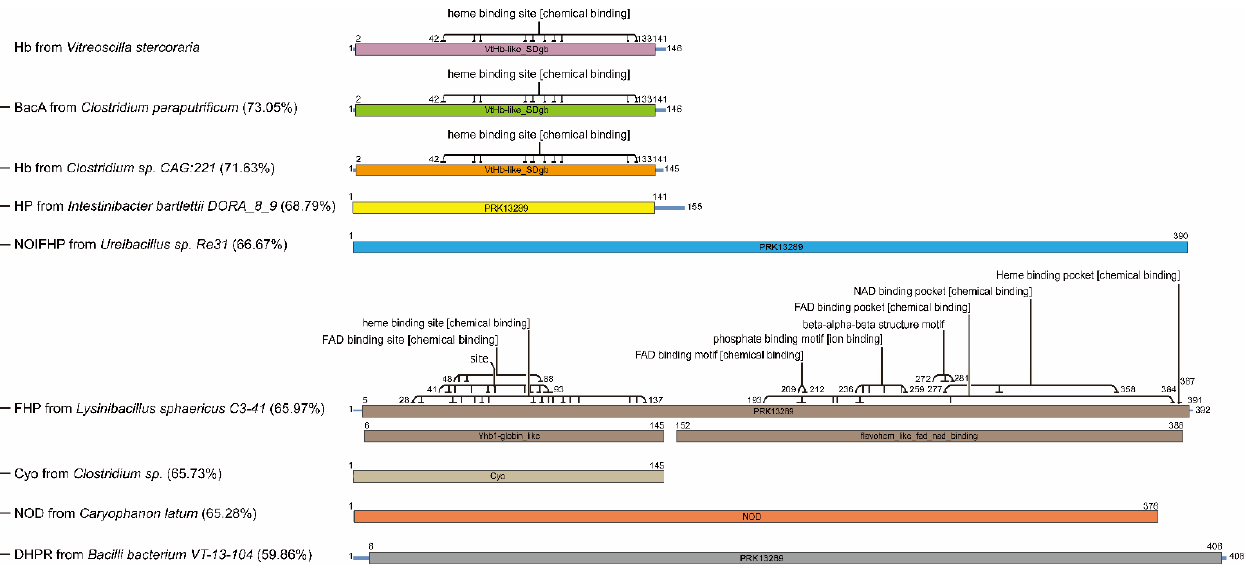
Figure 1. The homology analysis of VHb. The accession numbers in GenBank of eight homologous proteins and their homology with VHb: BacA from C. paraputrificum (WP_027099064.1, 73.05%), Hb from Clostridium sp. CAG:221